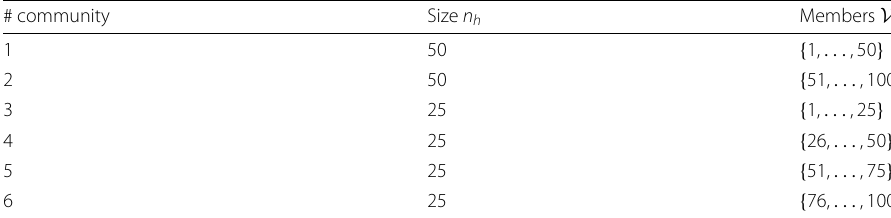
Table 3 Benchmark with hierarchical community structures # community